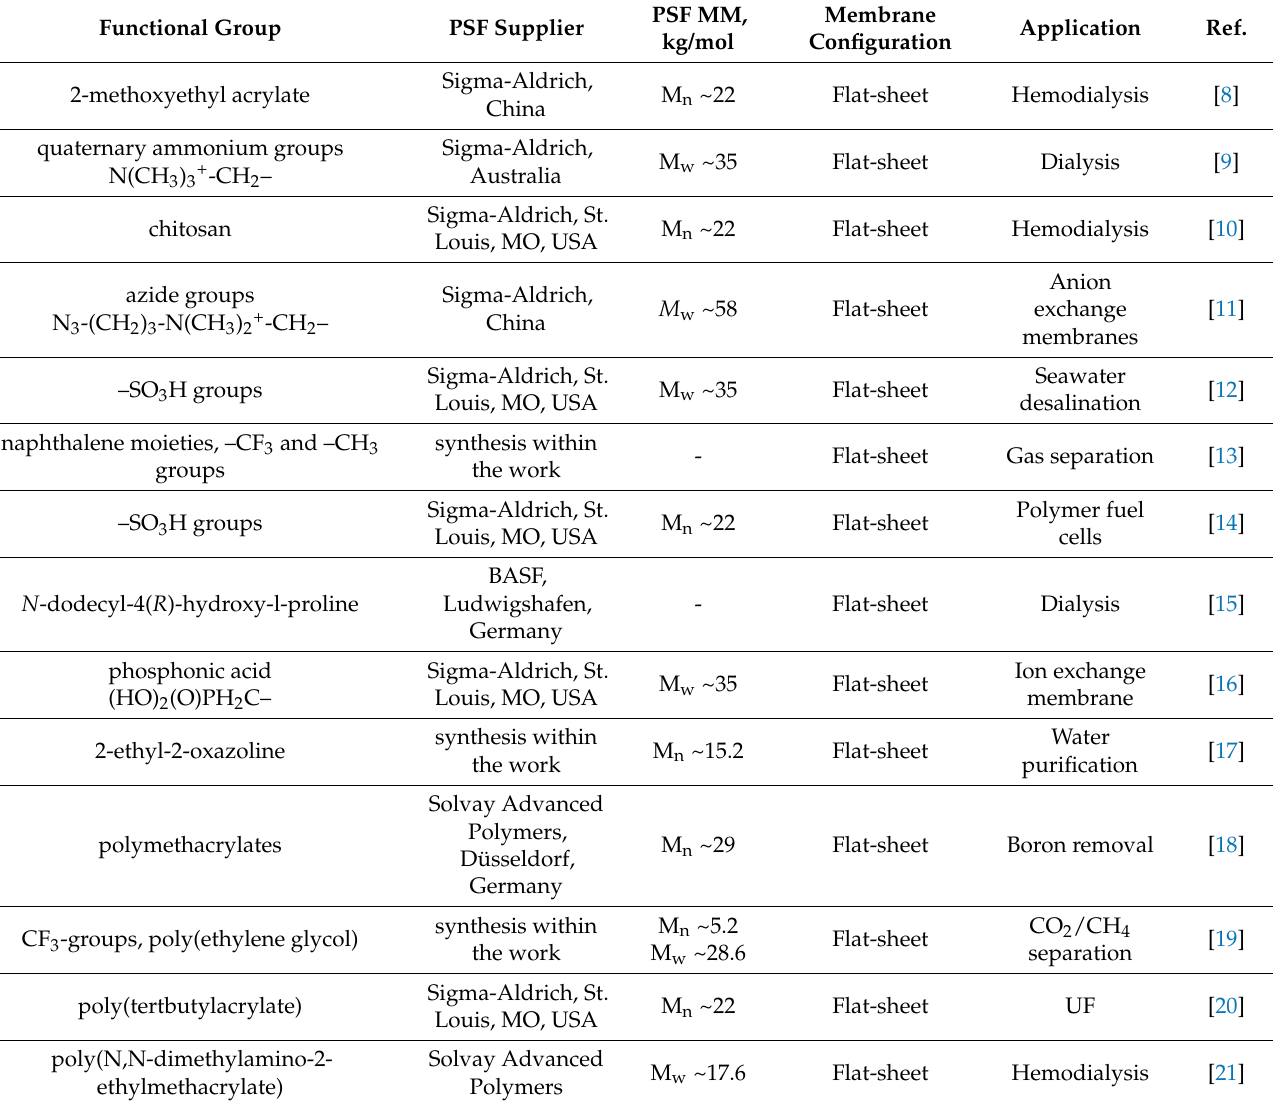
Table 1. Functionalization of PSF to produce membranes for targeted use (literature